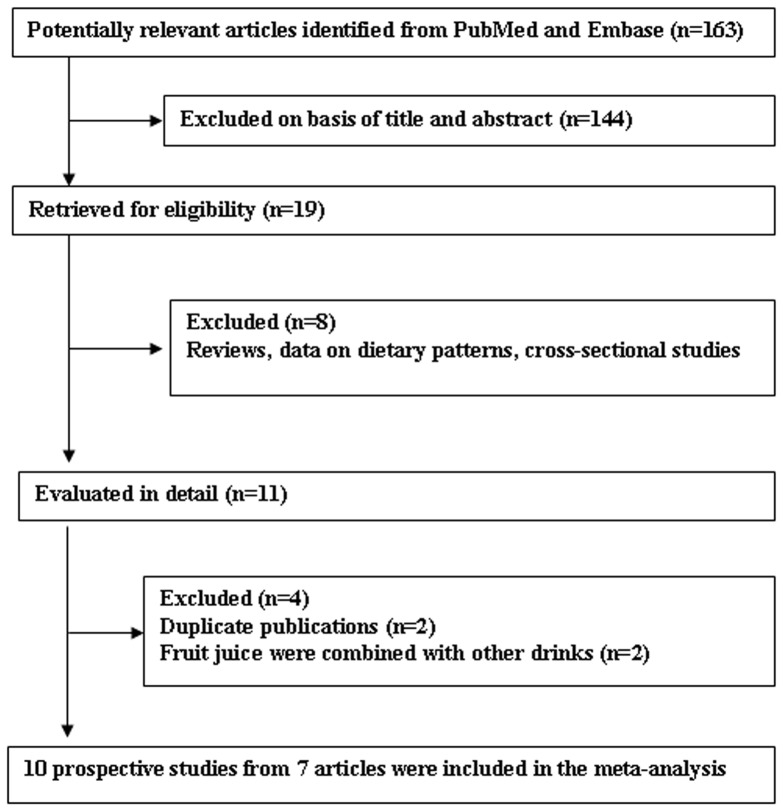
Process of study selection.